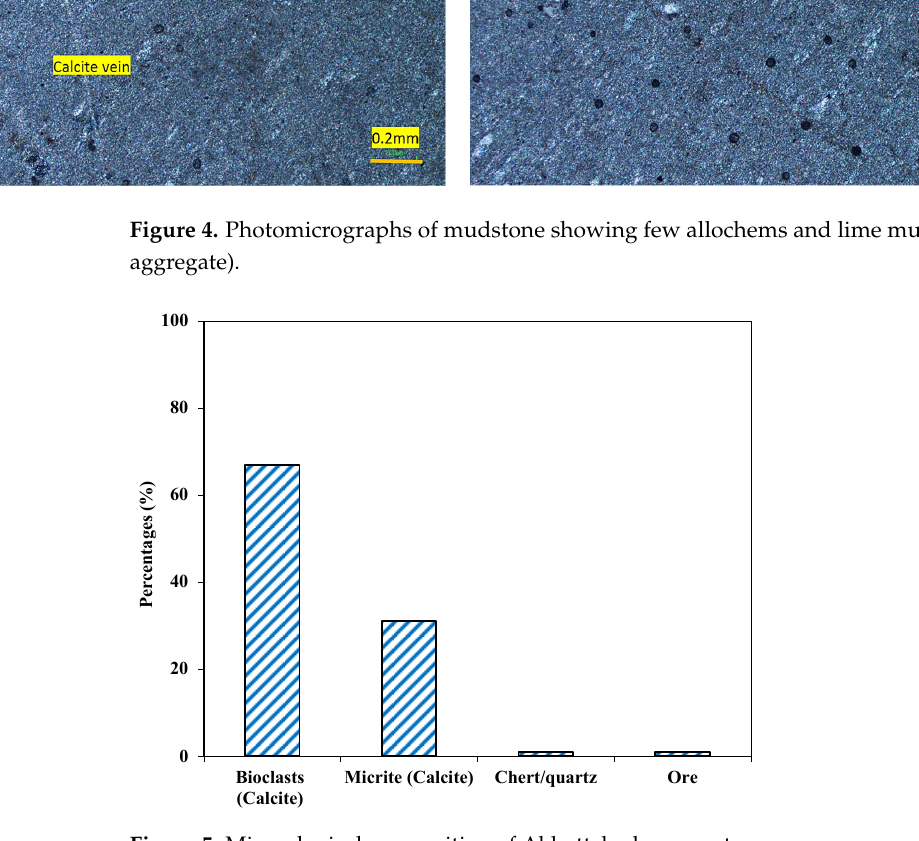
Figure 6. Photomicrographs of wackstone (Bioclastice limestone) showing allochems (Bioclasts) and lime-mud matrix (Abbottabad aggregate). According to Dunham classification [47], these aggregate samples consisted of more than 90% of calcite (CaCO 3 ) mineral, and therefore are suitable for use in concrete work as well as with asphalt provided the other required geo-mechanical properties (loss of abrasion, water absorption, compressive strength and porosity, etc.), as per project speci- fications, also lie within the permissible ranges. Owing to the heterogeneity in the rock types at the quarry, the material engineer is advised to monitor the supplied aggregate from time to time. 4.2.3. Orakzai Aggregate This aggregate sample consisted of two groups: limestone and quartzite. Limestone aggregate sample was medium grained and grayish in color. Based on petrographic anal- ysis, the sample was classified as packstone (limestone), with calcite forming more than 90% of the rock by volume (Figure 7a). Major components were fossils fragments (al- lochems) and lime-mud matrix. The bioclasts/fossil fragments ranged from 0.2 to 1.1 mm, whereas, the lime mud portion was fine grained. The broken fragments of fossils were partially recrystallized to spar. Quartz and chert (cryptocrystalline silica) and ores were also found, but these formed a very small portion of the sample, and hence were in the safe ranges as per ASTM C295 [39].